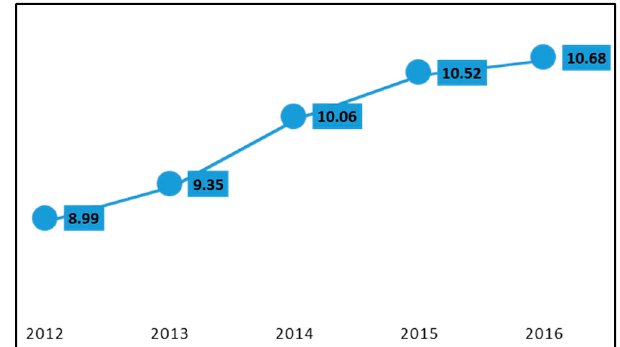
Figure 1. Youth unemployment rate trend.